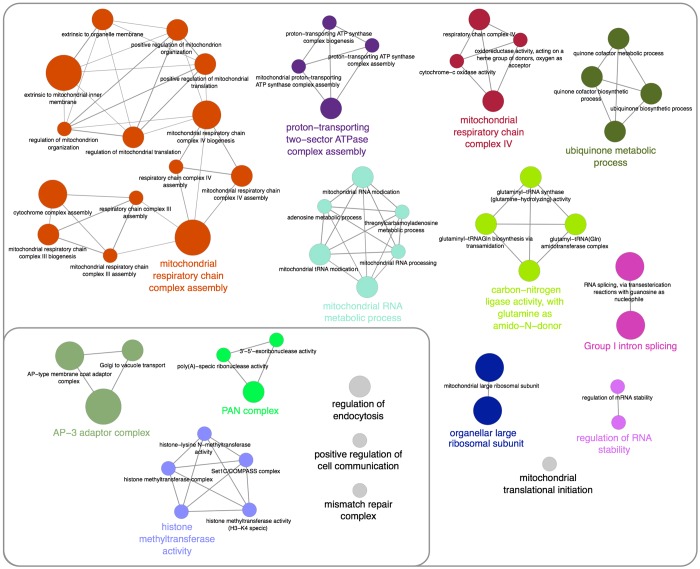
Functional enrichment in the yeast acid stress screen at pH 4. Enrichment for gene ontology (GO) groups was done using the ClueGO plugin and Cytoscape software. Nodes are coloured according to grouping of related functions by statistically significant association of related GO terms (ungrouped terms depicted as grey nodes) and groups are labelled according to the most significant term of the group. Node size corresponds to the significance of each GO term in the network and edges indicate statistically significant associations between GO terms. Functions related to mitochondria are shown in the larger area whereas other non-mitochondrial functions are shown in the smaller outlined area.